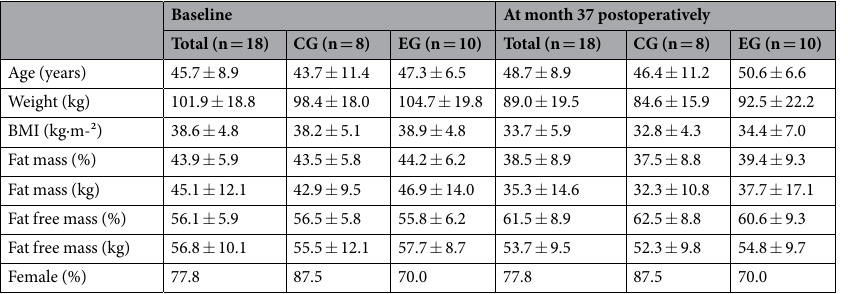
Table 1. Baseline characteristics of participants that completed the study. Data at the beginning of the follow-up (1 month after surgery), and at the start of the exercise program (37 months after surgery). CG, control group; EG, exercise group; BMI, body mass